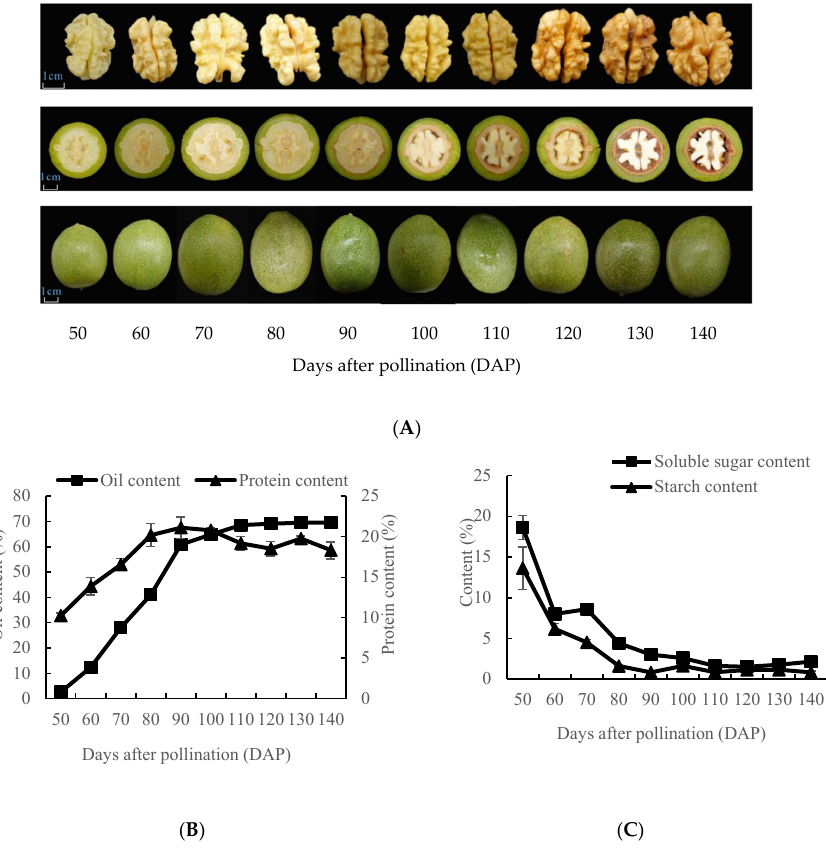
Figure 1. Changes in the morphological characteristics and indices of walnut fruits during development. ( A ) Fruit morphological characteristics at 50–140 DAP. The scale bar is 1 cm. The walnut embryos, transverse cuts of walnut fruits, and appearance of walnut fruit are shown in the above, mid ‐ dle, and below panels. ( B ) Embryo oil and protein content at 50–140 DAP. The y − axis on the left shows the oil content; y − axis on the right shows the protein content; the x − axis shows the different developmental stages. ( C ) Embryo soluble sugar and starch content at 50–140 DAP. The y − axis shows the soluble sugar and starch content; the x − axis shows the different developmental stages. The data were analyzed using three biological replicates. Standard deviations are shown with error bars. DAP, days after pollination.